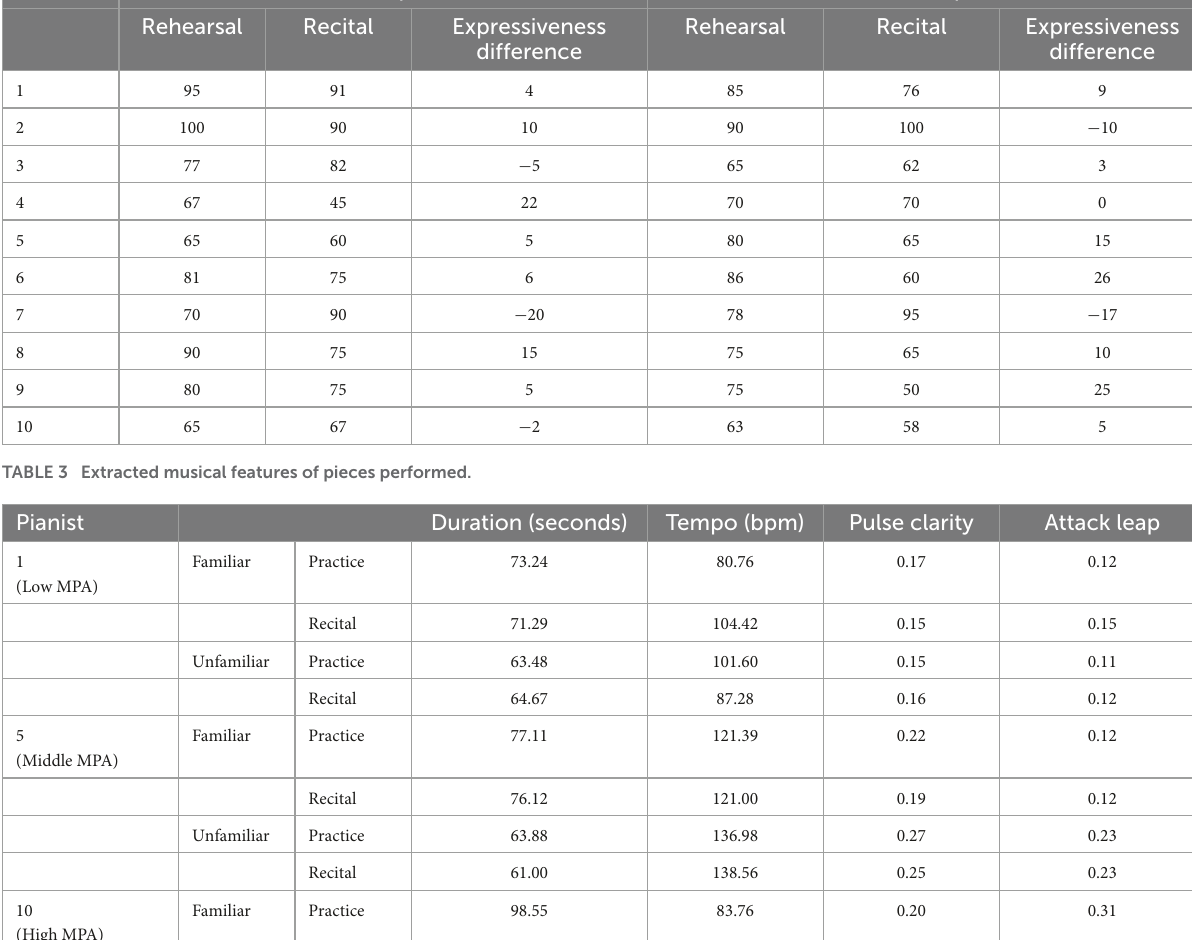
TABLE 2 Difference in pianist’s self-reported expressiveness, according to task mastery and situational stress. Pianist